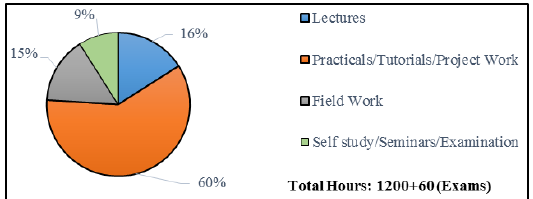
Figure 1. Course organization-percentage of